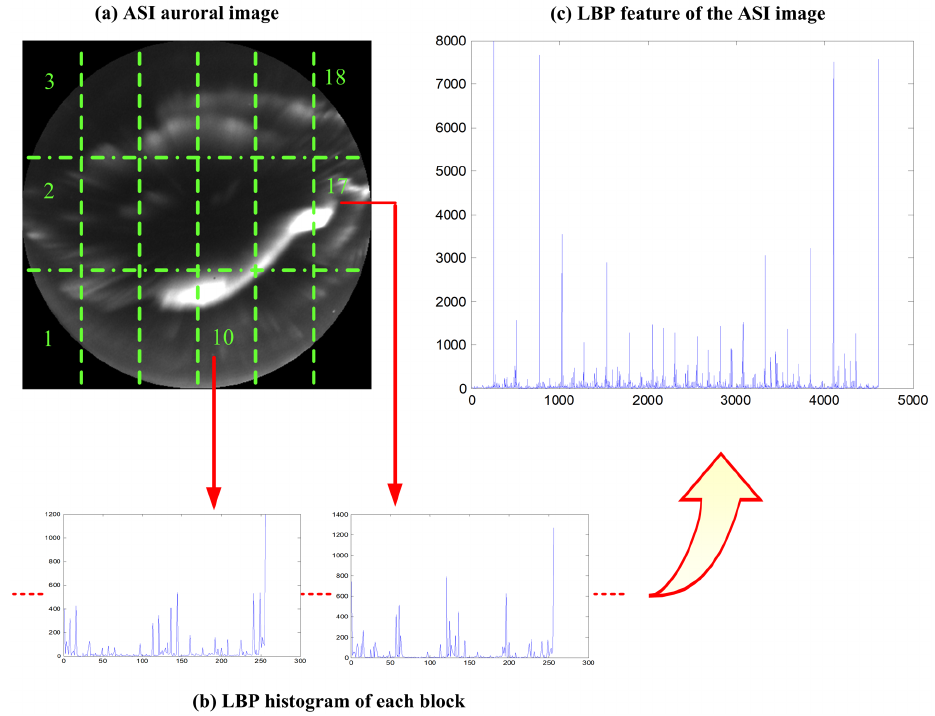
Figure 2. The LBP extraction process of the auroral image. The image illustrated was captured at 05:31:51 on 21 December